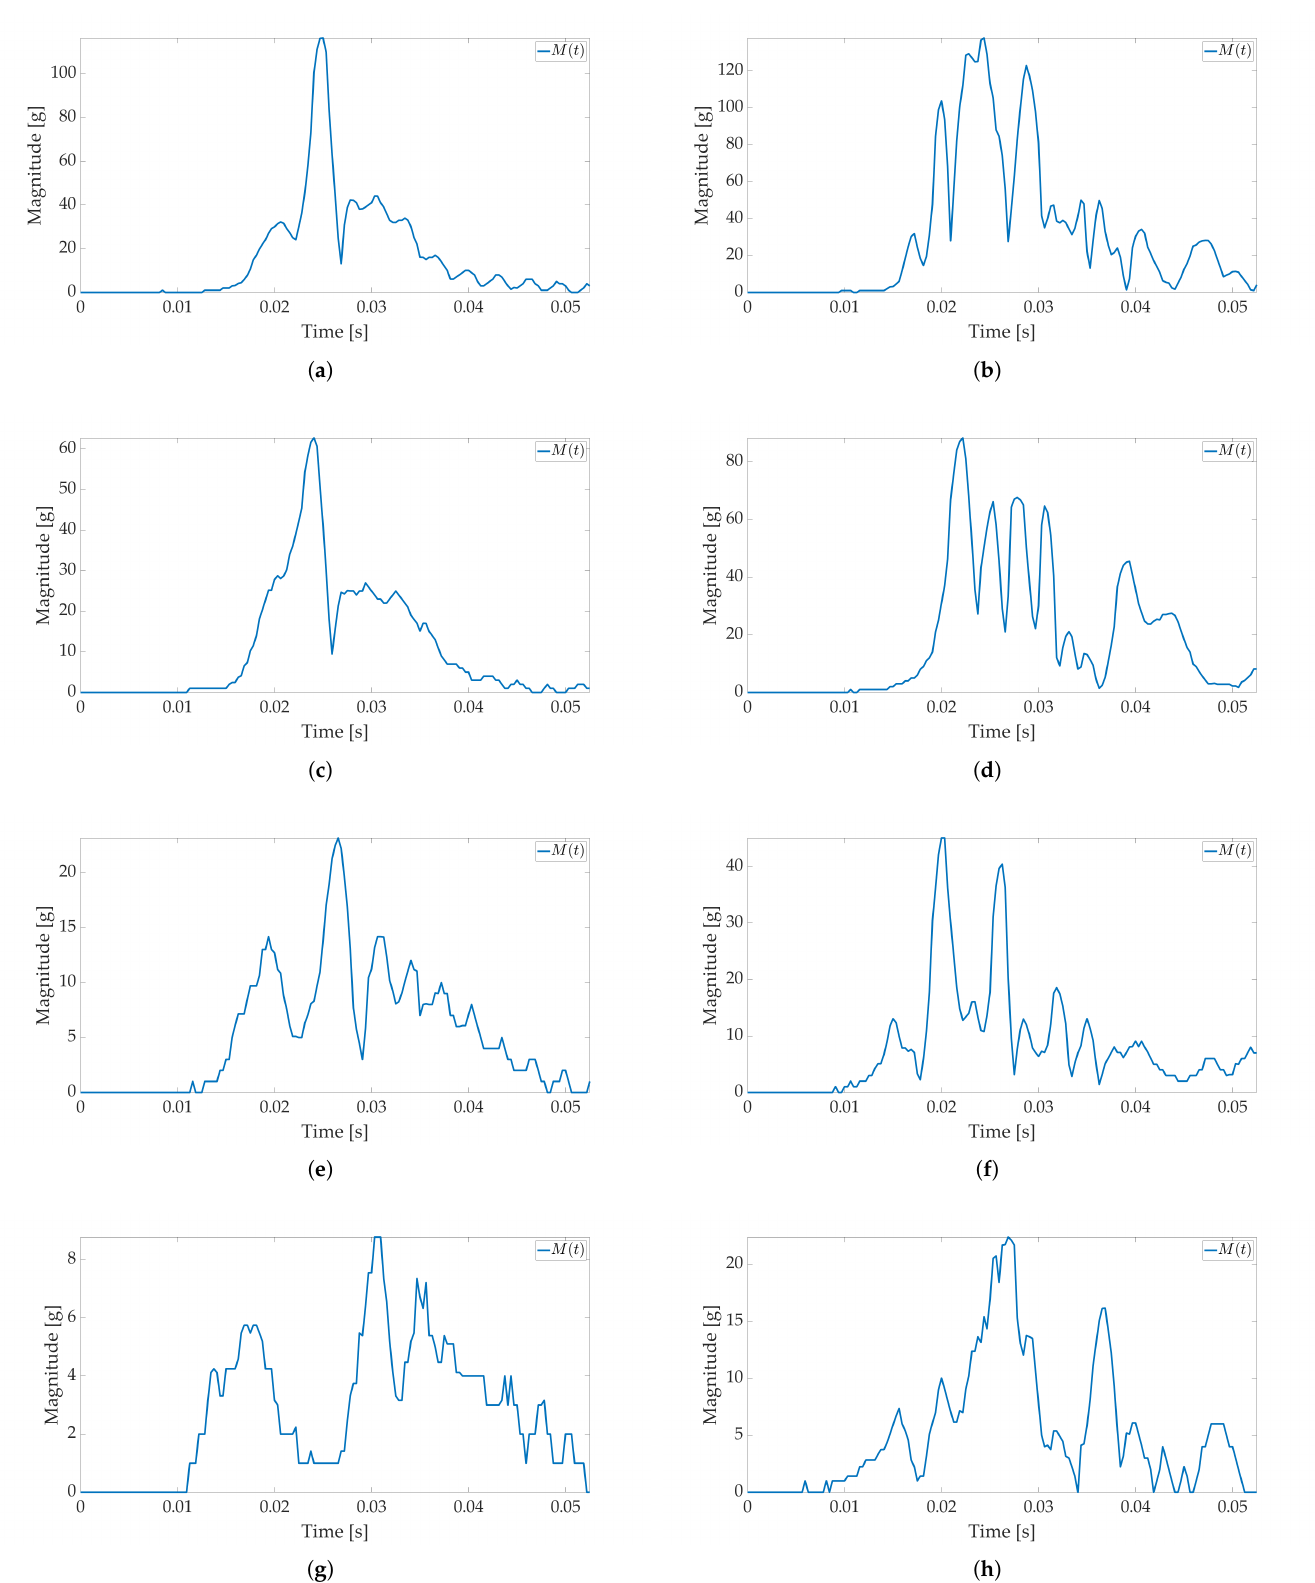
Figure 8. Shock detection values for package falling horizontally from various heights (3200 Hz with FIFO). Acceleration magnitude waveform: measured inside the package on figures ( a ) (100 cm), ( c ) (50 cm), ( e ) (20 cm), ( g ) (10 cm); measured on the package on figures ( b ) (100 cm), ( d ) (50 cm), ( f ) (20 cm), ( h ) (10